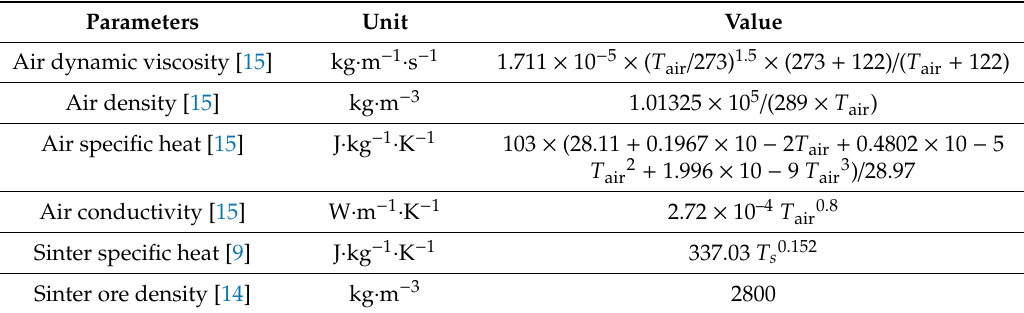
Table 2. Physical parameters of the sinter and gas